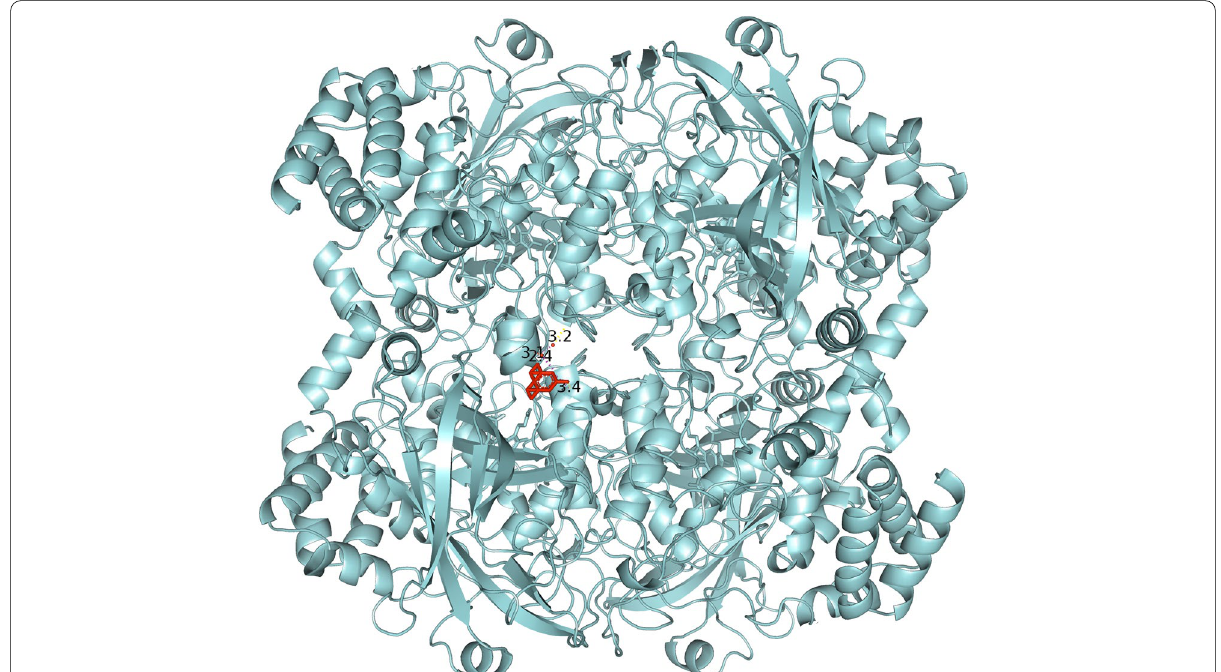
Fig. 4 General overview of the interaction between halogenated boroxine molecule and humane